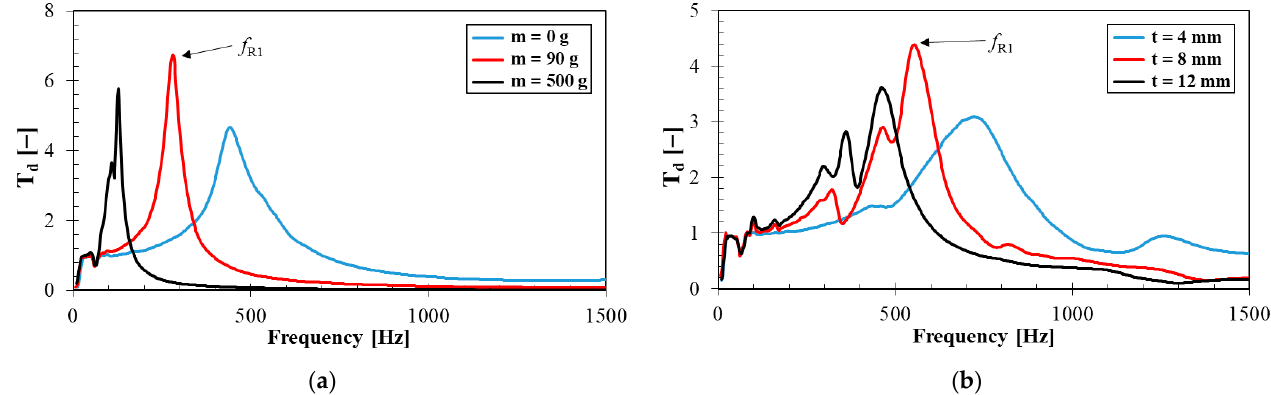
Figure 7. Frequency dependencies of the displacement transmissibility: ( a ) Rubber samples containing 20 phr of silica measuring t = 4 mm in thickness and loaded with different inertial masses; ( b ) rubber samples of various thicknesses containing 45 phr of silica and loaded with inertial mass m = 90 g.